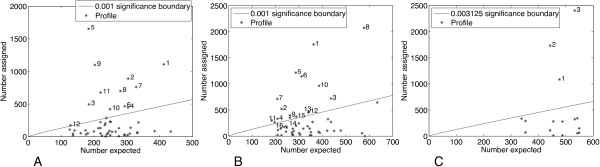
The significance of each cluster in A549 (A), Beas-2B (B), and MeT5A (C). The X-axis shows the number of expected probe sets and the Y-axis the number of assigned probe sets in each cluster. The clusters above the line are considered statistically significant based on permutation tests.